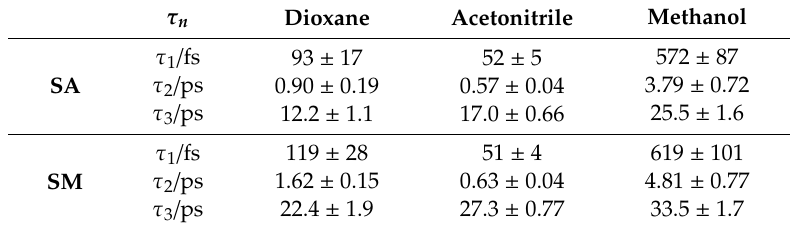
Table 1. Summary of lifetimes of dynamical processes of SM and SA. Reproduced and adapted with permission from [104], licensed under CC-BY. © 2015 American Chemical Society.